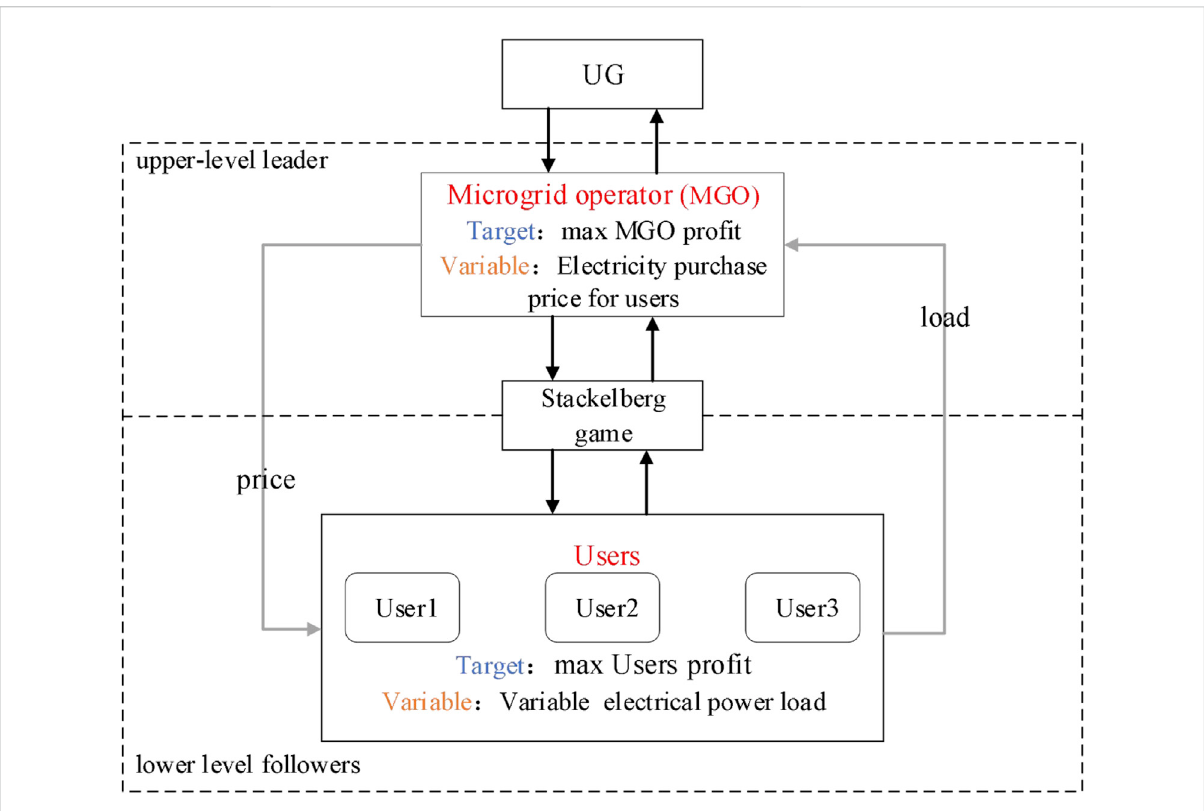
FIGURE 2 Schematic diagram of the GCMG Stackelberg game